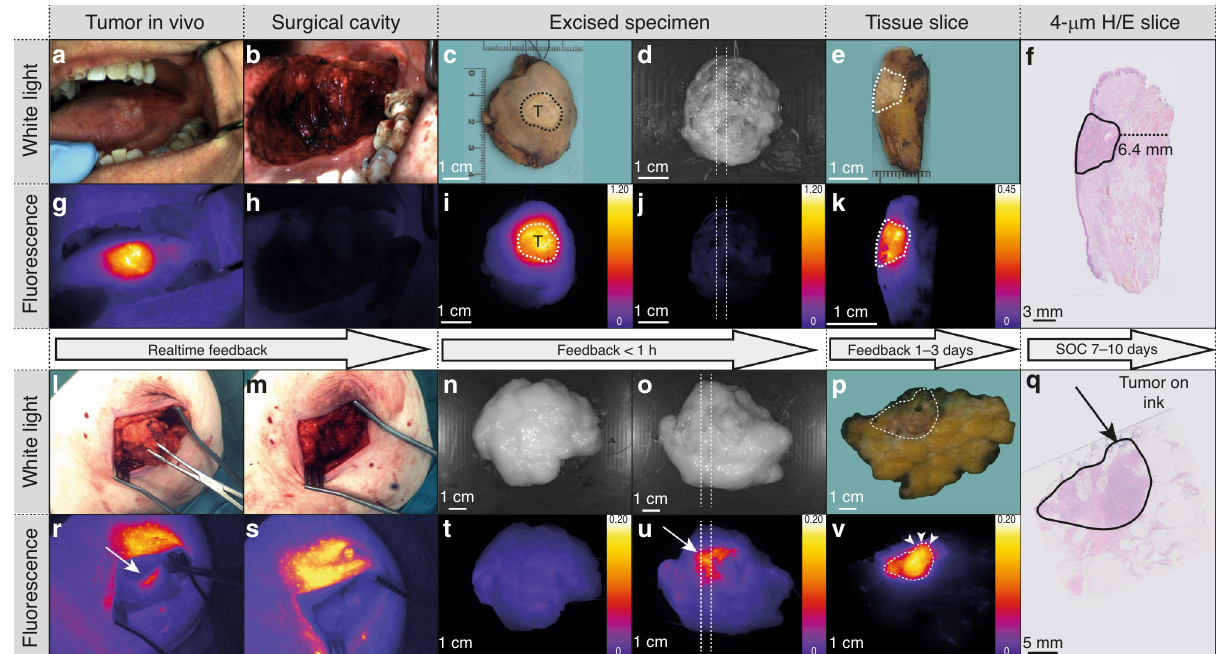
Fig. 4 Fluorescence-guided assessment of surgical margins. Representative example of a head and neck squamous cell carcinoma of the tongue from a subject with a negative surgical margin. In- and ex vivo visualization of fl uorescence in the tumor ( a , c , g , i ) with no fl uorescent signal in the surgical cavity or at the surgical resection margin ( b , h , d , j ). Correlation of fl uorescent signals on a tissue slice with the histology ( e , k , f ) with a tumor-negative surgical margin of 6.4 mm. Representative example of breast cancer surgery (i.e., a lumpectomy) with a tumor-positive surgical margin ( l , m , n , o ). Fluorescence is detected at the ventral surgical resection margin both in vivo and immediately after excision ( r , s , t , u ) which corresponds with the fl uorescence localization on the tissue slice ( p , v ) and the fi nal histopathology ( q ). The tumor is delineated as a solid black line on the H/E slices ( f , q ). H/E hematoxylin eosin, SOC standard of